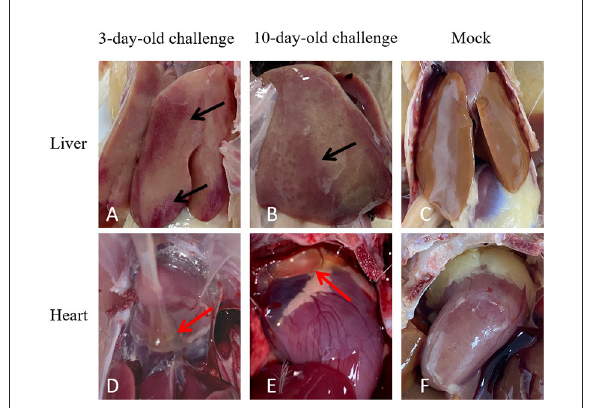
FIGURE6 Pathogenicity analysis of FAdV-2 strain GX01. Clinical signs were observed in the challenge and negative control groups at 21 days post infection: livers enlargement and hemorrhage (Black arrow) and hearts mild hydropericardium (Red arrow). (A,B) Abnormal liver in 3-day-old challenge group and 10-day-old challenge group respectively. (C) Normal liver in mock group. (D,E) Abnormal heart in 3-day-old challenge group and 10-day-old challenge group, respectively. (F) Normal heart in mock